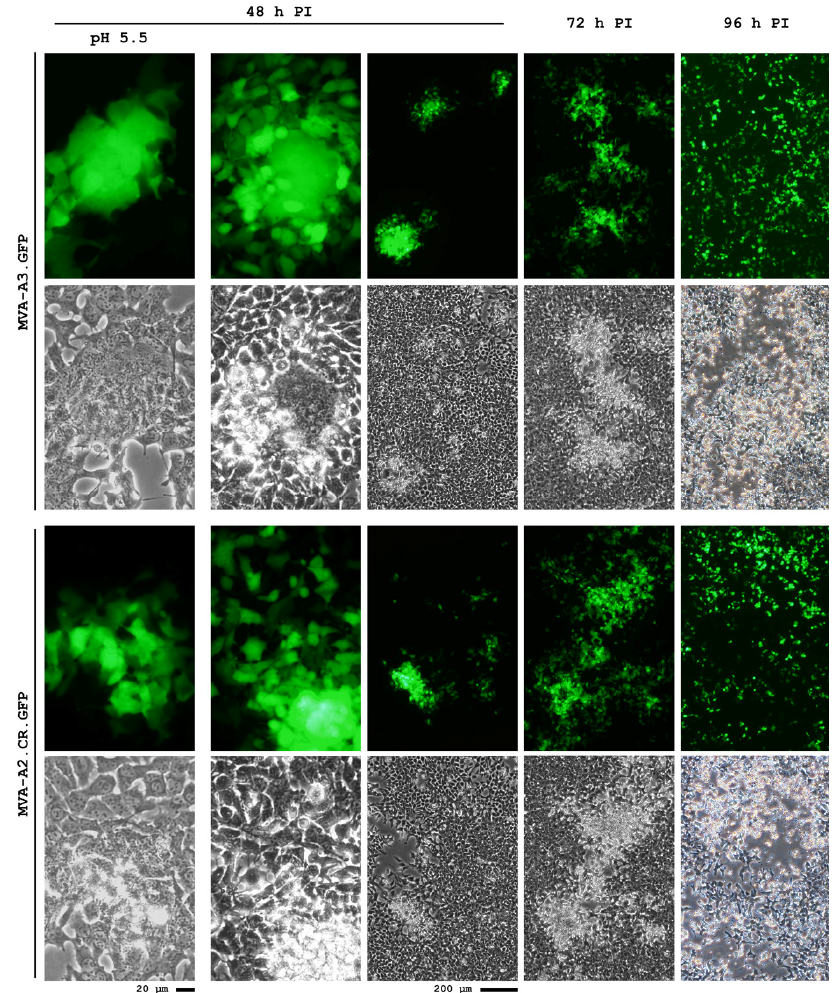
Figure 6. Plaques of recombinant virus containing the MVA-CR genotype mutations in the backbone of wildtype virus exhibit a larger fraction of scattered cells and fewer spontaneous syncitia. Synthetic DNA containing the mutations of the MVA-CR genotype in the three genes were recombined into a wildtype MVA, together with GFP as reporter into deletion site III, obtaining the virus MVA-A2.CR.GFP. A wildtype MVA that also contains GFP in deletion site III is designated as MVA-A3.GFP. CR.pIX cell monolayers were infected with a MOI of 0.01. Column marked with pH 5.5 header denotes syncitia induction by pH shock at 30 h post